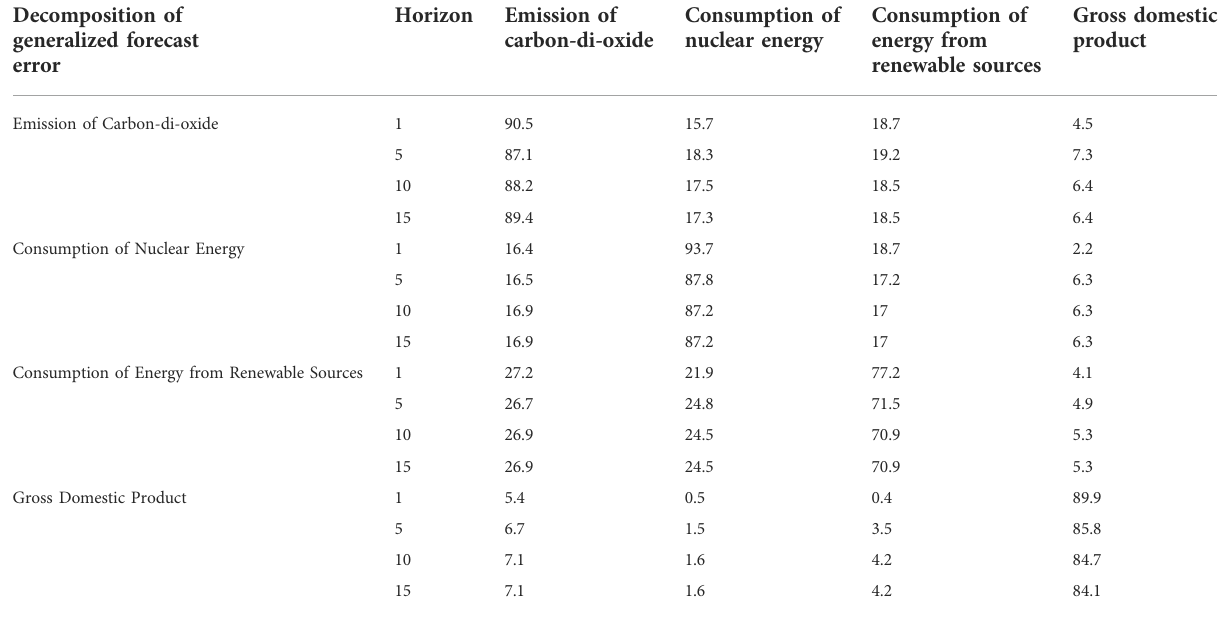
TABLE 3 Generalized forecast error variance decomposition. Decomposition of generalized forecast